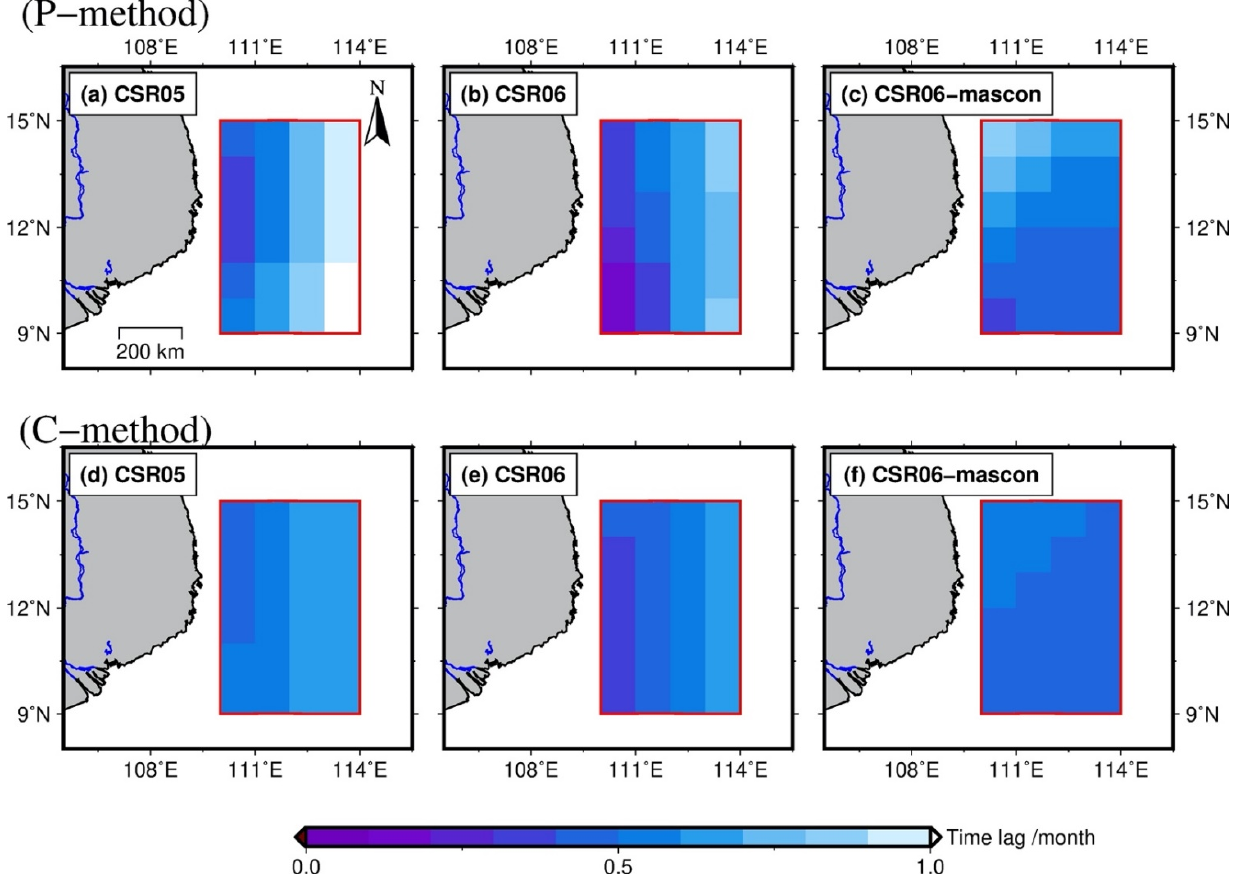
Figure 7. Spatial distribution of time lag for CSR05, CSR06 and CSR06-mascon using the P-method ( a – c ) and C-method ( d – f ), respectively, between March 2006 and February 2009, such that the median time epoch is 1 September 2007.